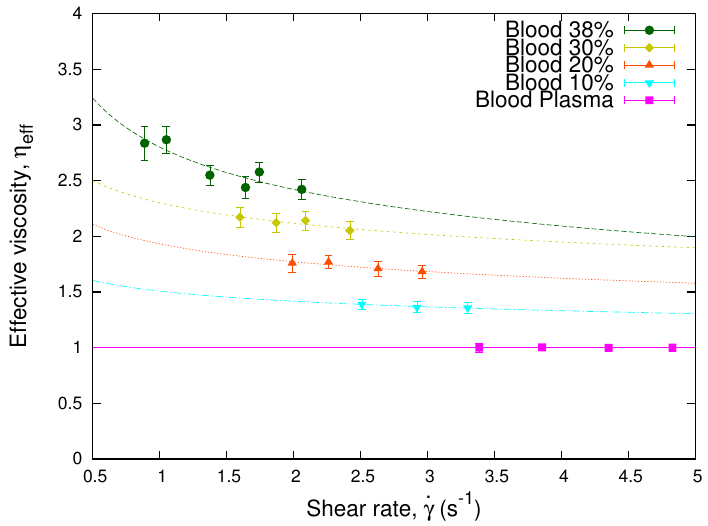
Figure 3. Effective viscosity vs. shear rate. The plot shows the effective viscosity, obtained through Equation (14), as a function of the shear rate, ˙ γ = ˙ h / b , of a blood sample separated in different RBCs concentrations and blood plasma. The lines represent the fits obtained through Equation (2) for the different effective viscosities. The values of the exponents of the samples are n = 0.80 for the 38% sample, n = 0.87 for the 30% sample, n = 0.87 for the 20% sample, and n = 0.91 for the 10% sample, which coincide with those obtained in Figure